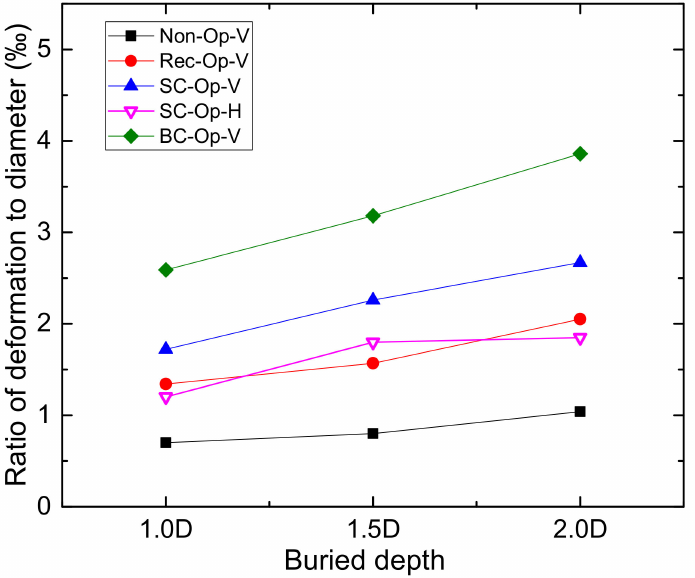
Figure 11. Variations of the ratio of deformation to diameter versus buried depth.